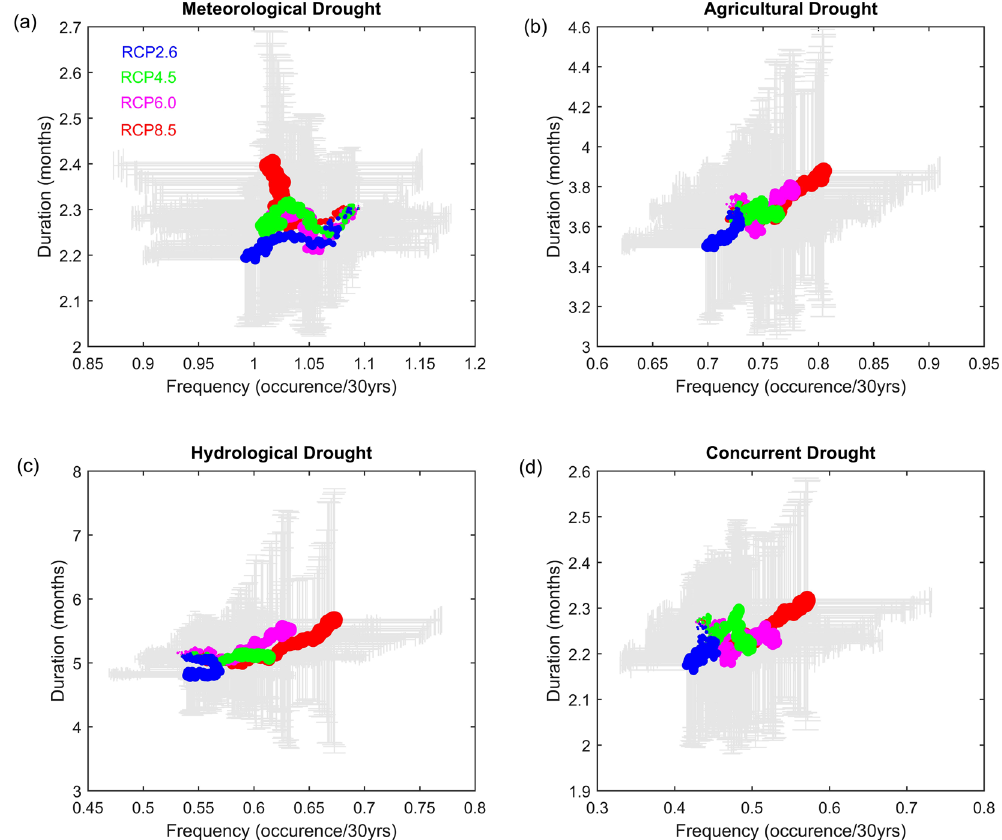
Figure 3. Changes in relations between US mean frequency and duration of ( a ) meteorological, ( b ) agricultural, ( c ) hydrological and ( d ) concurrent droughts by CMIP5-VIC simulations under RCP8.5, RCP6.0, RCP4.5 and RCP2.6 scenarios. Dots represent the multi-model ensemble mean values while error bar is for the one standard deviation to show the model ranges. The size of dots are scaled by global warming amount to characterize the regional changes in drought frequency and duration relations with global warming. For example, larger dots indicate larger global warming amounts or later future period given that global mean temperature exhibits an evident increasing trend with time, although there is small variation at the interannual scale. Figure was created using software MATLAB 2015a